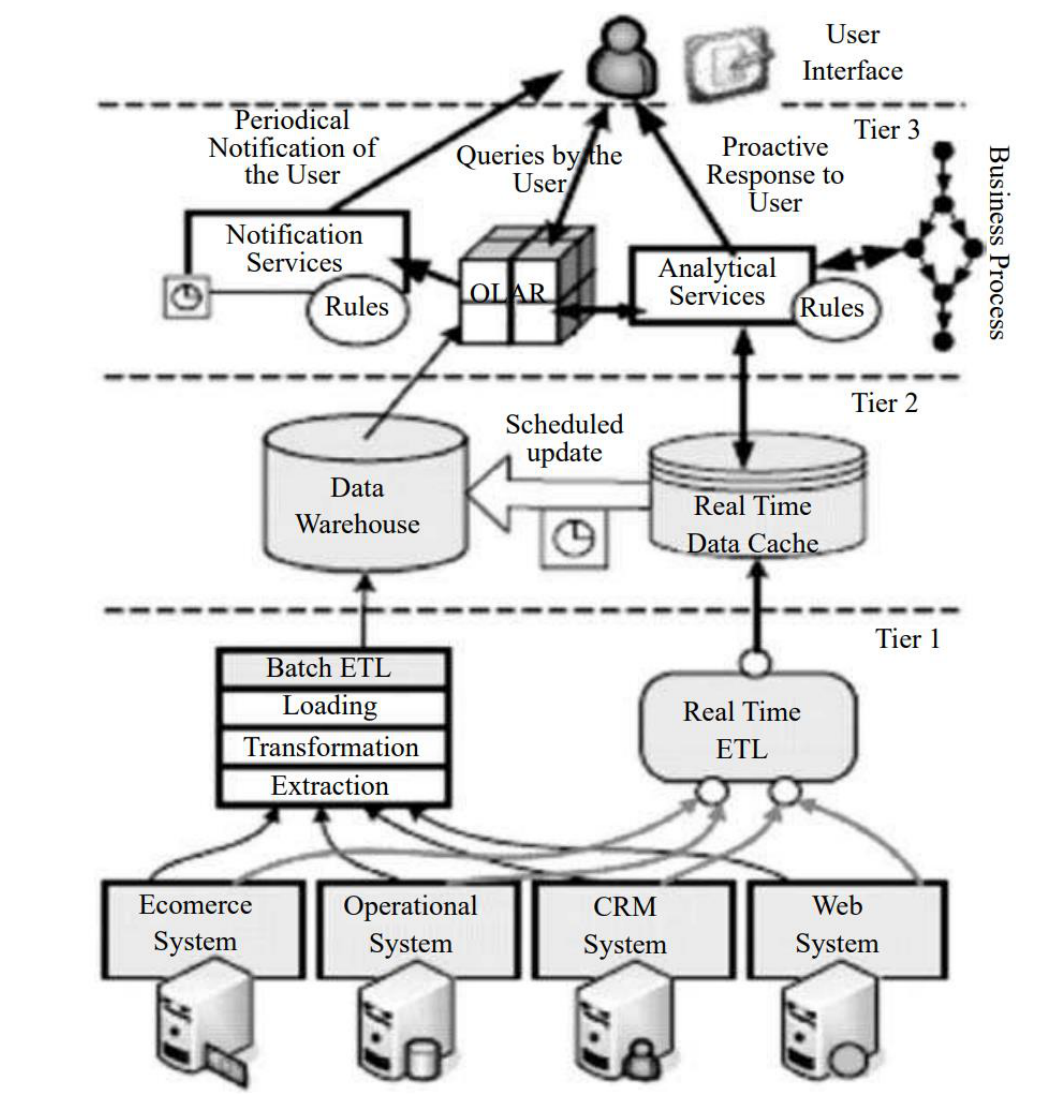
Figure 3: The process of BI (Source: Taylor (2004)) Actual time BI for supply chain analytics lessens choice cycle procedures. It responds to the